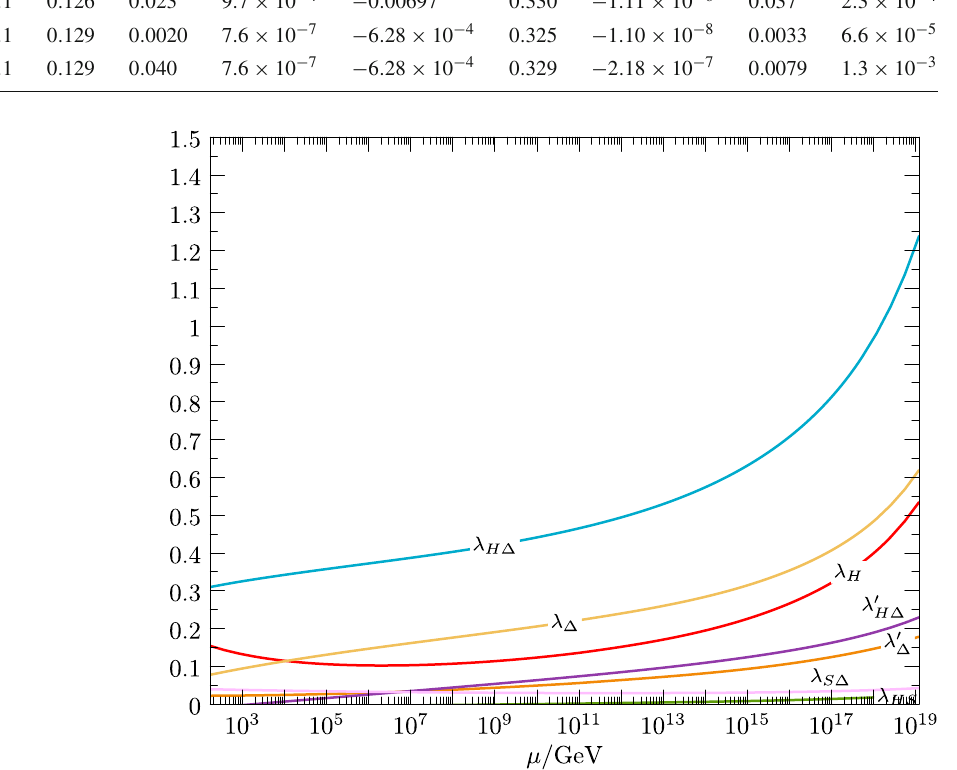
Table 1 A few benchmark points with δ m = 0 GeV, v δ = 0 . 1 GeV and λ δ = 0 . 1 that satisfy all constraints